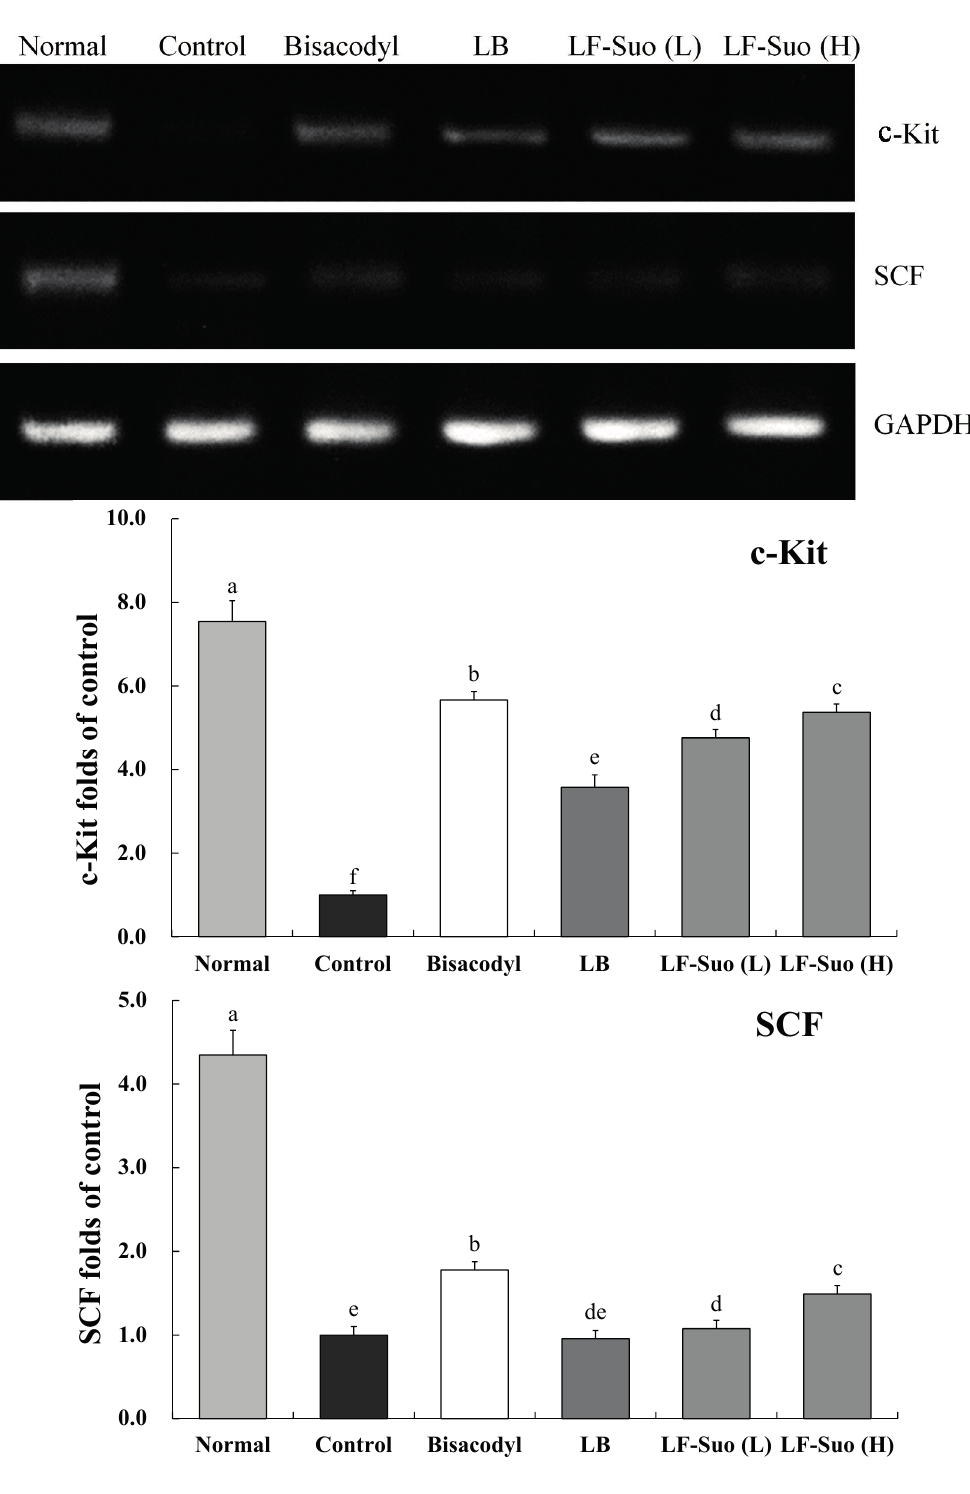
Figure 4. Effects of Lactobacillus fermentum Suo on the mRNA expression of c-Kit and SCF in small intestine. n = 10 ICR mice in each group, bisacodyl: 100 mg/kg b.w.; LB: Lactobacillus bulgaricus (1.0 × 10 9 CFU/kg b.w.); LF-Suo (L): Lactobacillus fermentum Suo (0.1 × 10 9 CFU/kg b.w.); LF-Suo (H): Lactobacillus fermentum Suo (1.0 × 10 9 CFU/kg b.w.); a–f Mean values with different letters over the bars are significantly different ( p < 0.05) according to Duncan’s multiple range